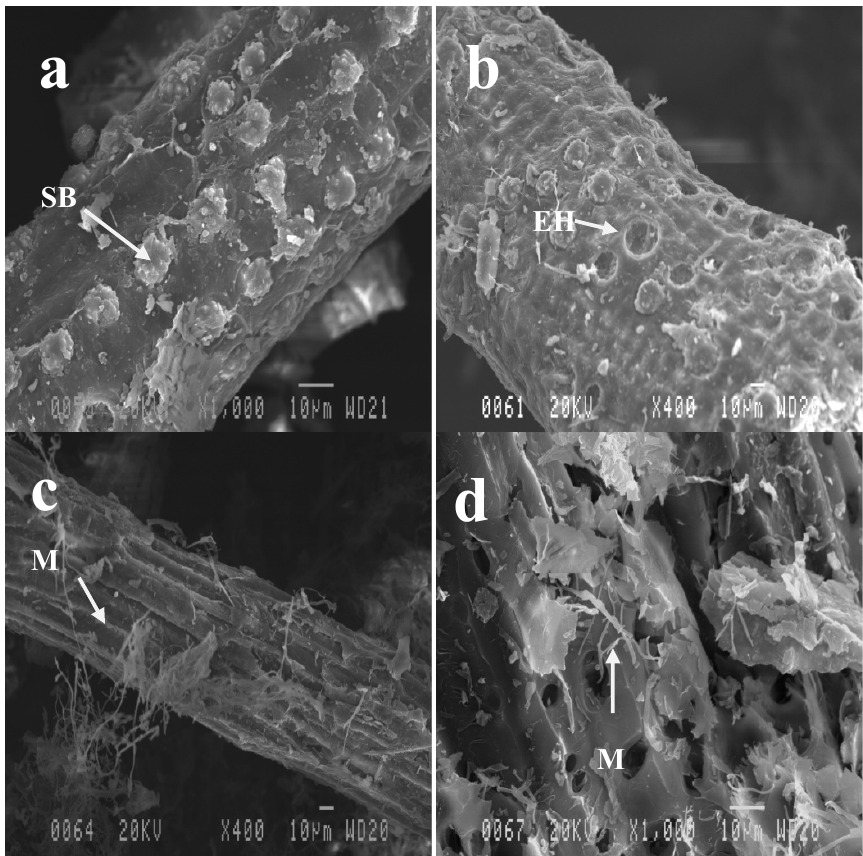
Figure 4. Fibre surface of untreated Oil palm empty fruit bunches (OPEFB). ( a ) Untreated OPEFB, ( b ) fungal pretreated OPEFB, ( c ) fungal pretreated OPEFB strand covered by fungal mycelium, ( d ) cross section of fungal pretreated OPEFB. SB = silica body, EH = empty hole, M =